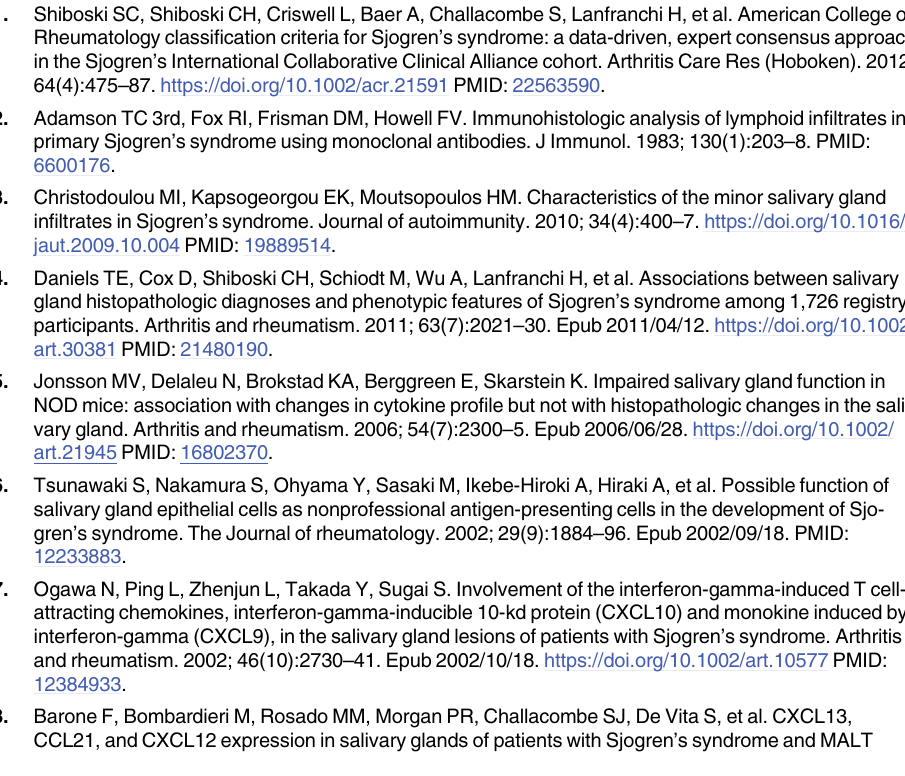
S1 Table. The list of medications. S2 Table. Genera a associated with control vs.